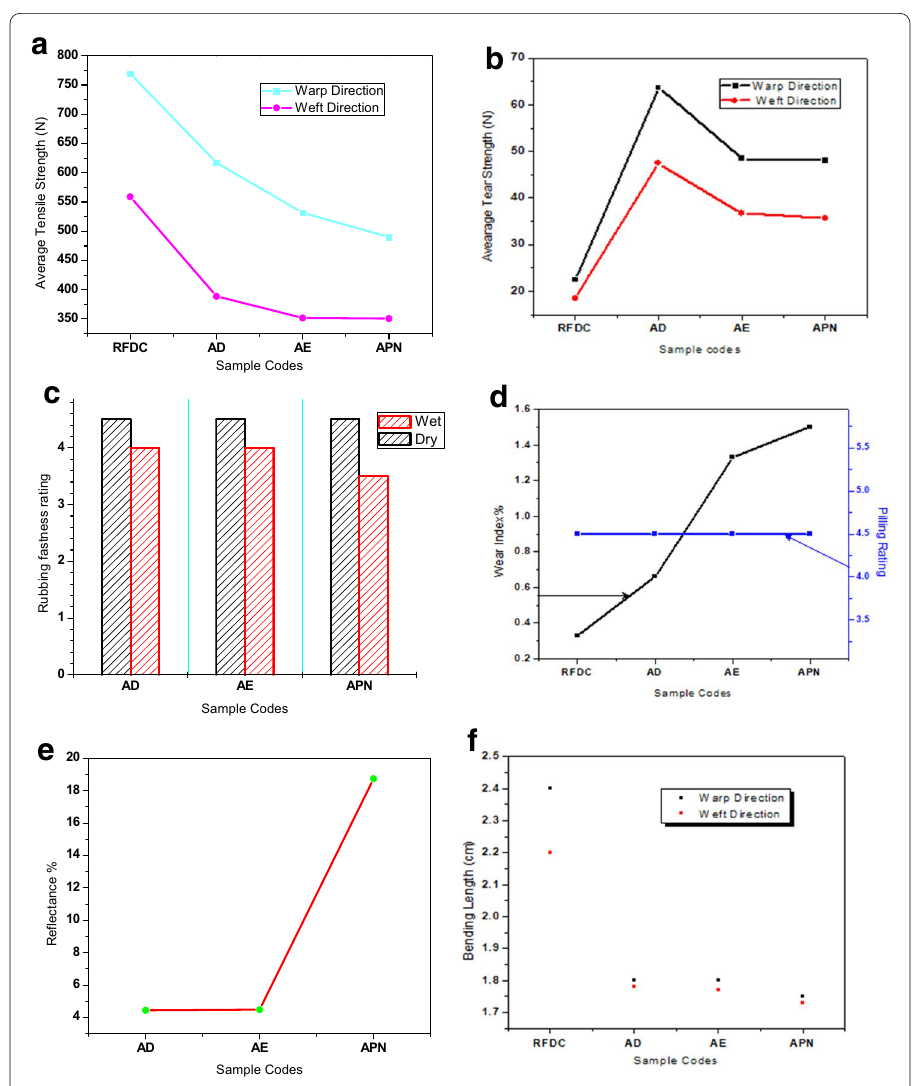
Fig. 7 a Tensile strength at warp and weft direction. b Tear strength at warp and weft direction. c Rubbing fastness test restults at wet and dry condition. d Wear index% and pilling rating in various stages. e Reflectance% test results and f Stiffness test results based on bending length (cm). RFDC Ready For Dyeing Canvas, AD After Dyeing, AE After Enzyme, APN After PP Followed by PP